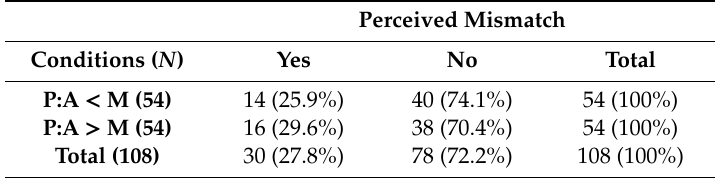
Table 12. Count and proportion (%) of perceived mismatch amongst (in)congruent